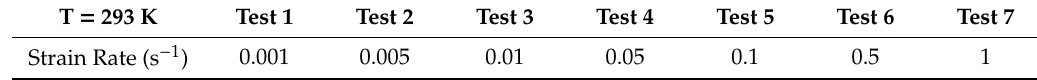
Table 2. Quasi-static test conditions at room temperature (293 K).